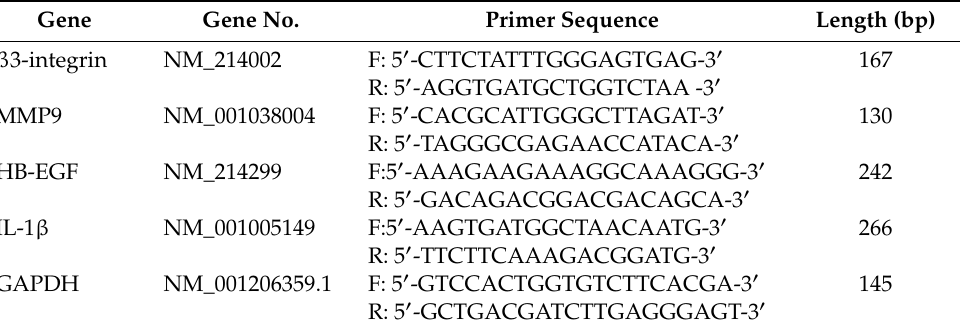
Table 1. The sequences of